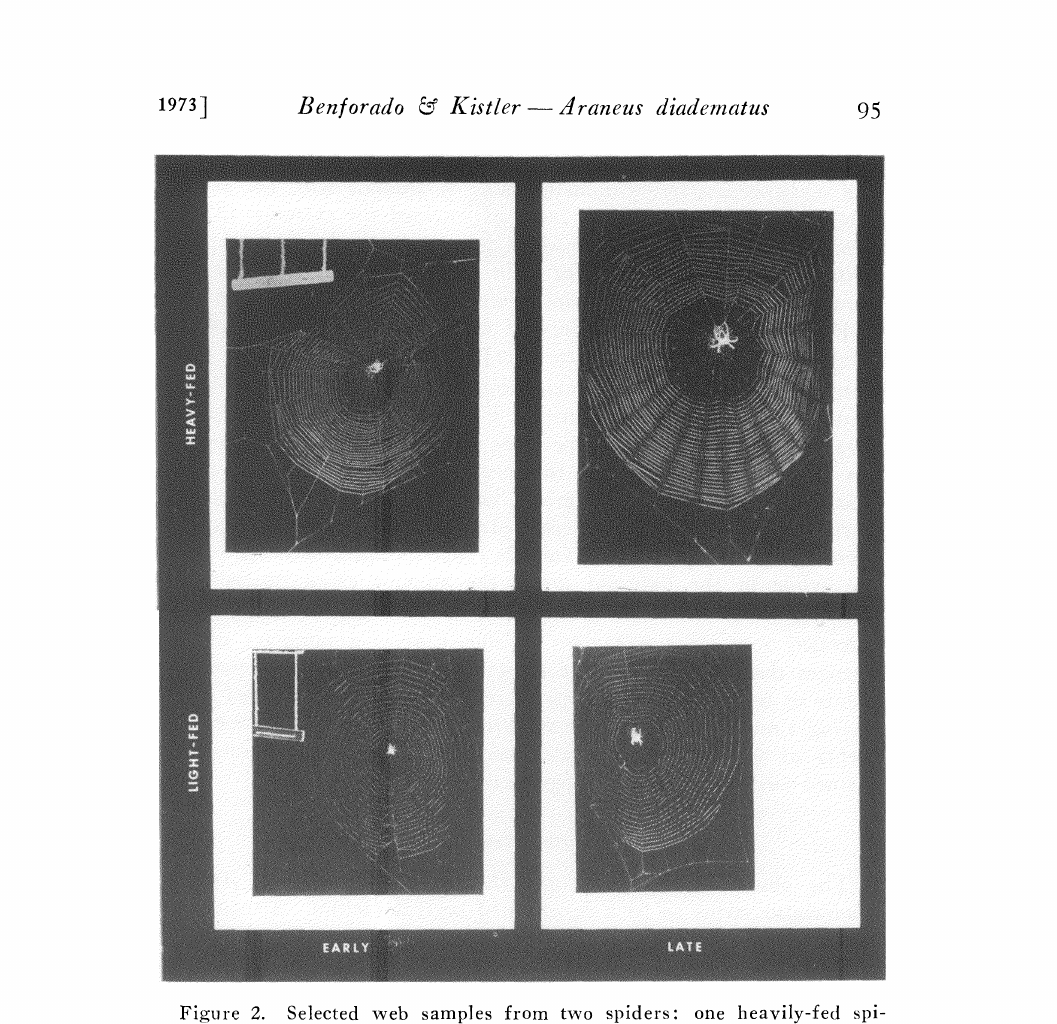
Figure 2. Selected web samples from two spiders: one heavily-fed spi- der and one light-fed spider. Webs are from the periods measured in and are all reproduced to the same scale. Note that while both the heavy-fed, and light-fed animals began with webs of similar size, after two weeks of differential feeding the large, heavy-fed spiders’ webs had increased in size while the webs ef the small, light-fed spiders remained the same